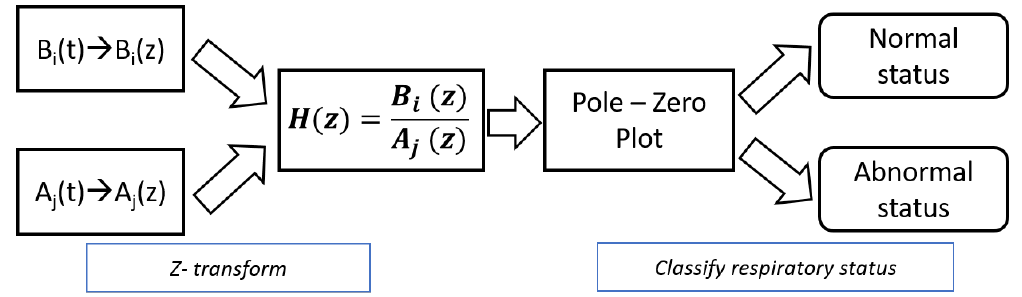
Figure 4. Overall flow of approach to detect respiratory status ( A j ( z ) ) given one respiration ( B i ( z ) ).